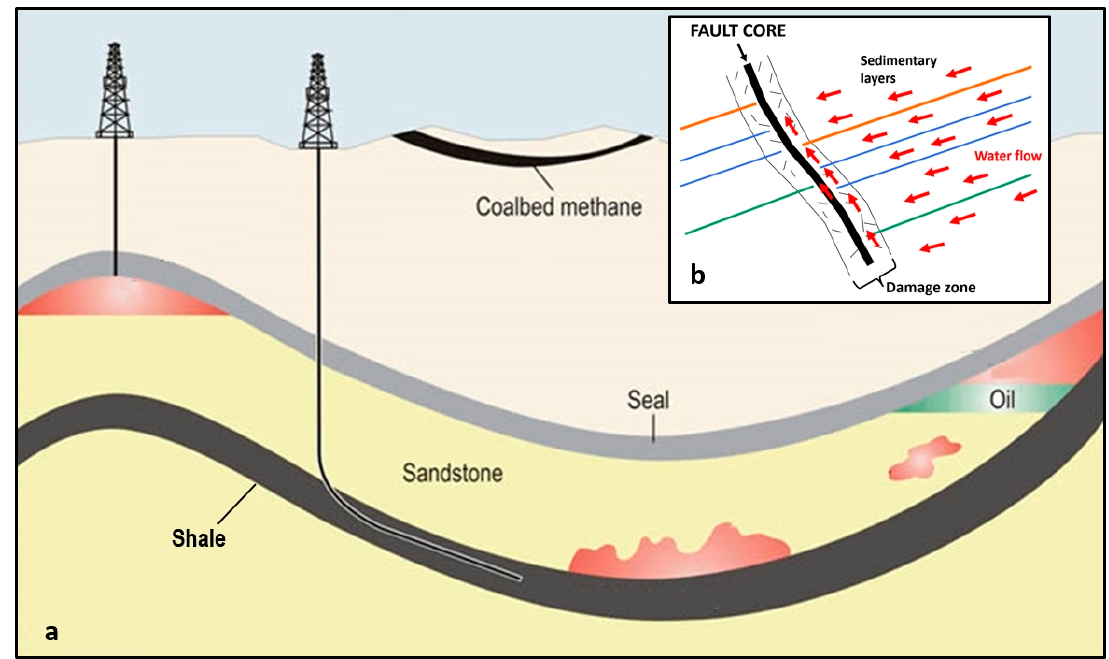
Figure 1. ( a ) Conventional and unconventional oil and gas location in geological structures. This cartoon, from the US Energy Information Administration, shows simple US-style geology with a thin, unfaulted shale layer. ( b ) Cross-section of water flow up a fault zone. The core, central part of a fault (black) may either be transmissive or else be a barrier. The damage zone on either side, comprising fractured rock, will usually be transmissive. The resulting conceptual water flow from right to left is indicated by red arrows.